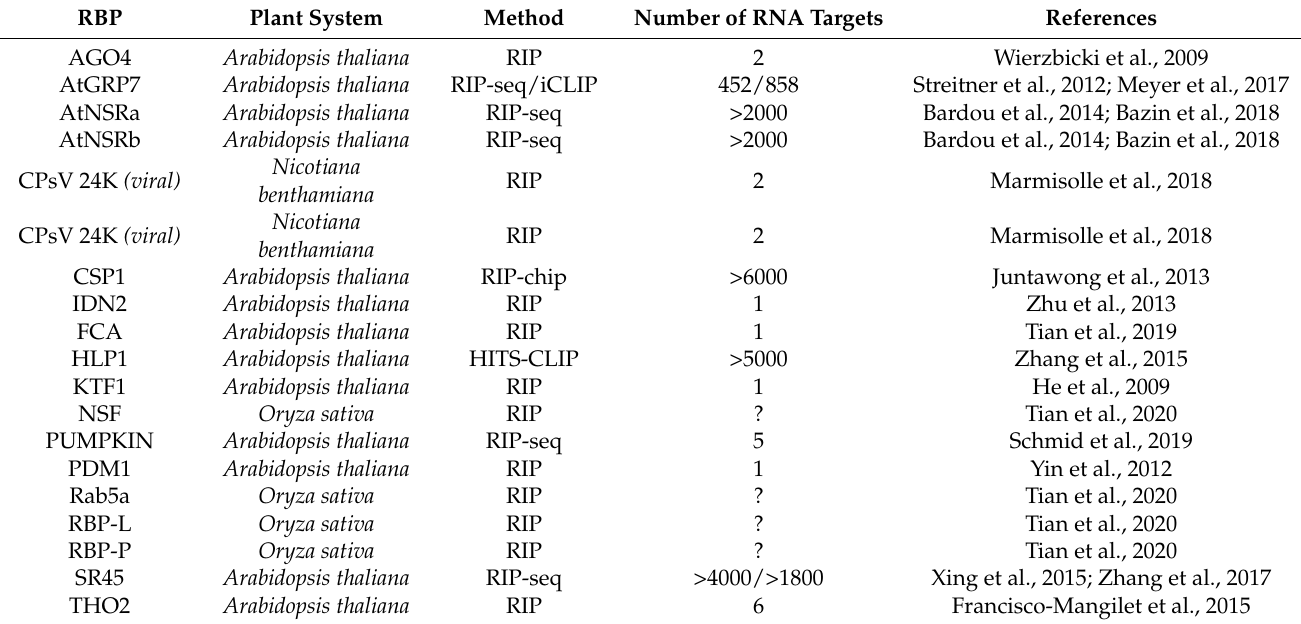
Table 2. Summary of Plant RBPs Identified by Baited RNA-Protein